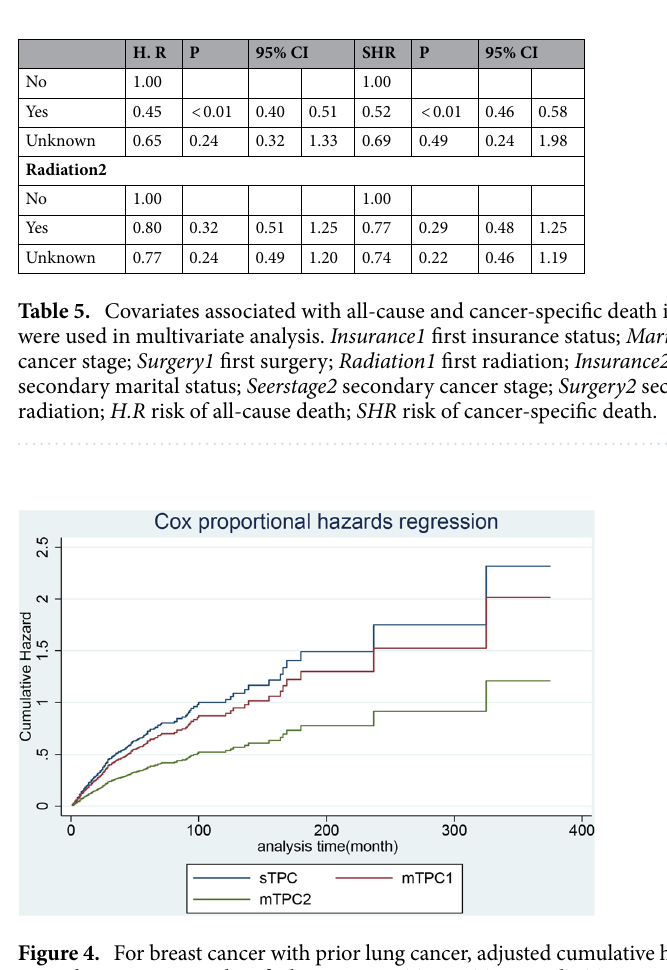
Figure 4. For breast cancer with prior lung cancer, adjusted cumulative hazard of all-cause mortality since secondary cancer was classified into group sTPC, mTPC1 and mTPC2.